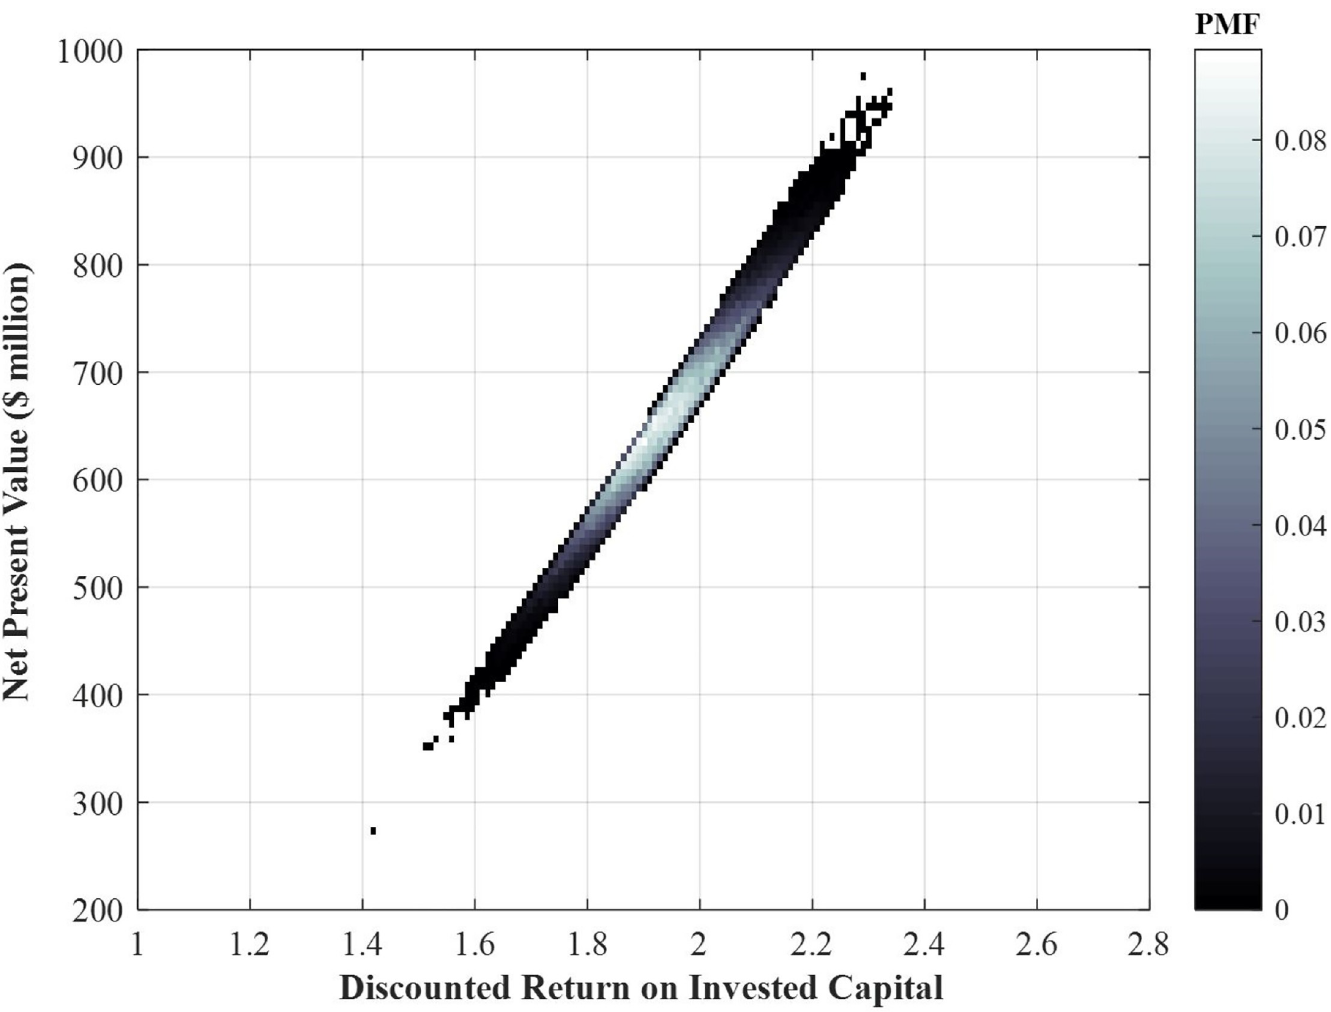
Fig 11. Joint distribution histogram of the NPV and d-ROIC for the medium-sized HTS under the nominal-case scenario after a design life of 15 years.